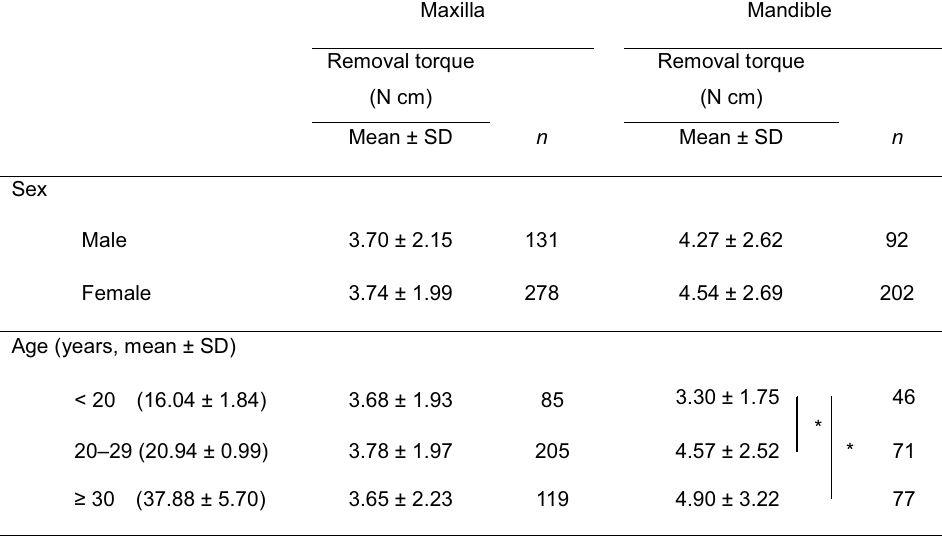
Table 3 Comparison of removal torque according to sex and age